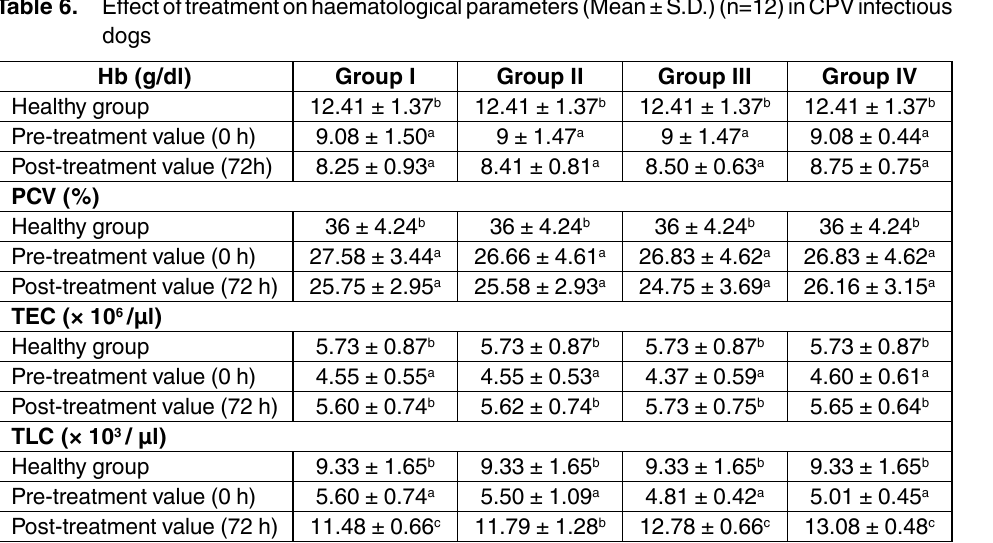
table 6. Effect of treatment on haematological parameters (Mean ± S.D.) (n=12) in CPV infectious